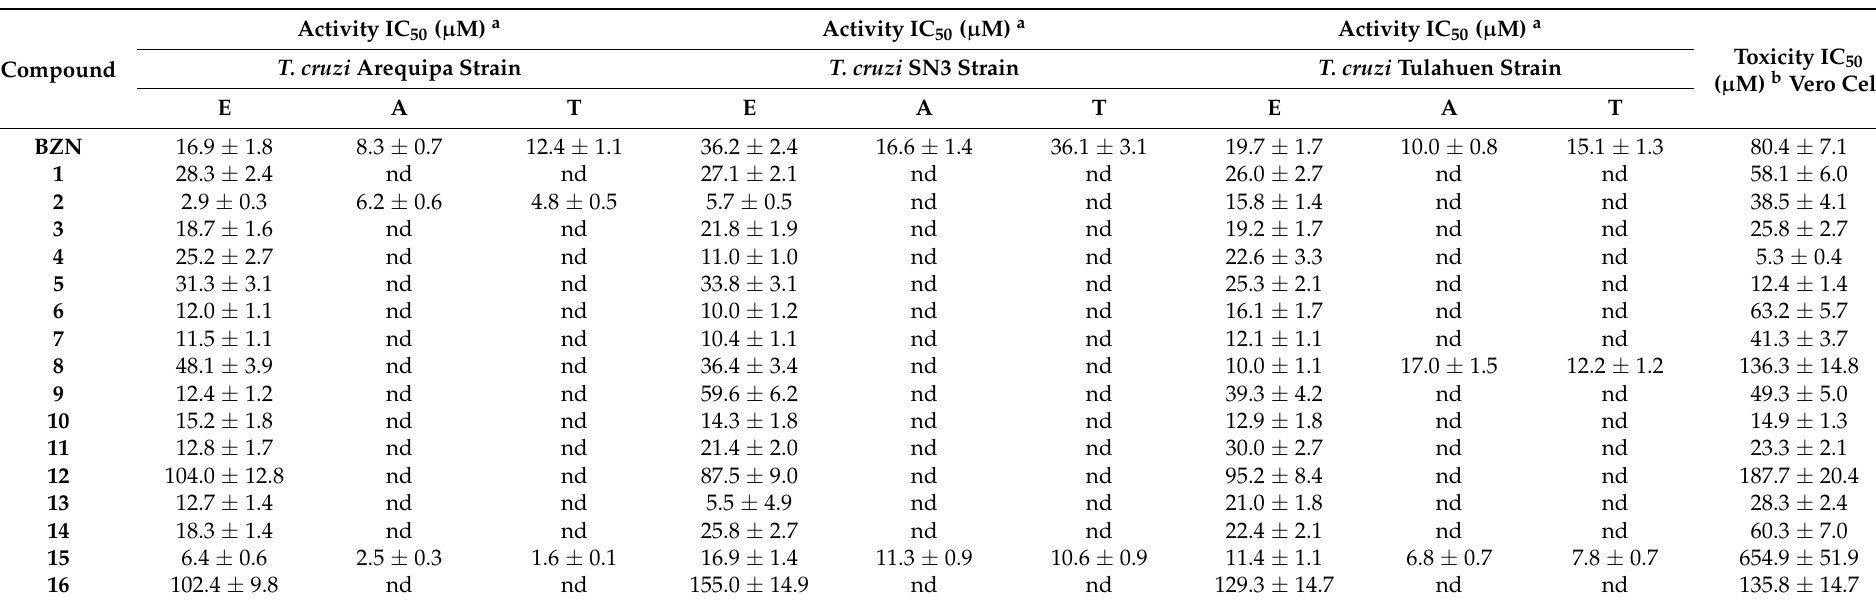
Table 1. Activity of benznidazole and compounds tested against the three developmental forms of Trypanosoma cruzi , and toxicity on mammalian Vero cells.